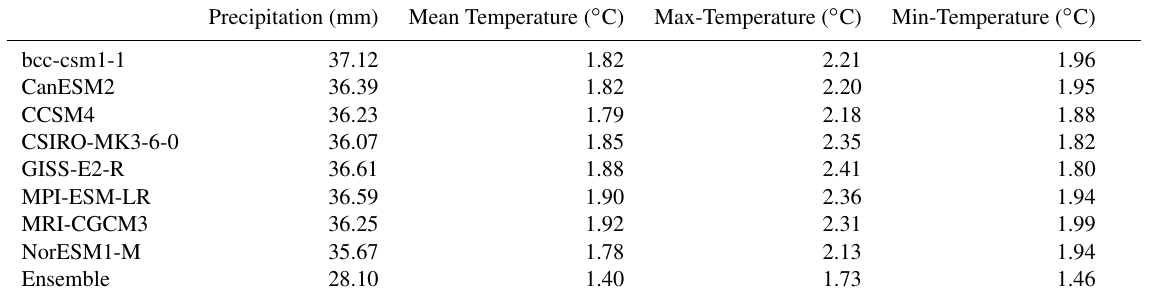
Table 2. The RMSE of monthly precipitation and temperature between observed and downscaled model simulated in YRB from 1961–2005. Precipitation (mm) Mean Temperature ( ◦